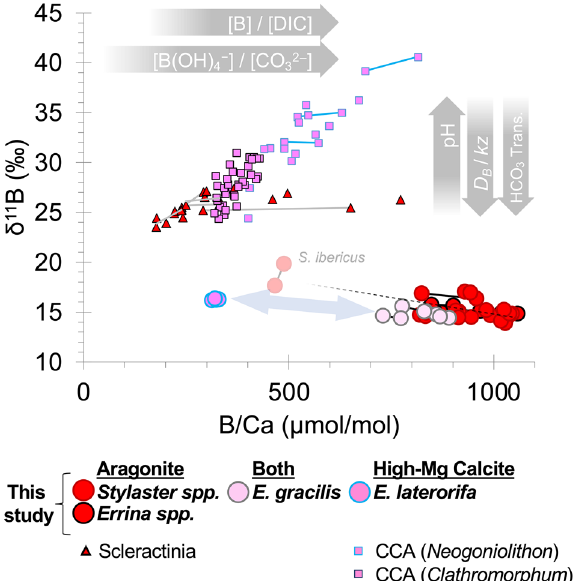
Figure 4. Carbonate B/Ca against δ 11 B. Stylasterid B/Ca and δ 11 B replicate results (this study) are compared to fibrous aragonite within scleractinia ( D. dianthus ) 47 , and crustose coralline algae (CCA 18,21 ). Individual analyses from the same specimens are connected by solid trend lines (2 analyses or more). Dashed trendline shows the covariance between all aragonitic stylasterid measurements (p < 0.01). Blue arrow shows theoretical mixing line between solely aragonitic and solely high-Mg calcitic